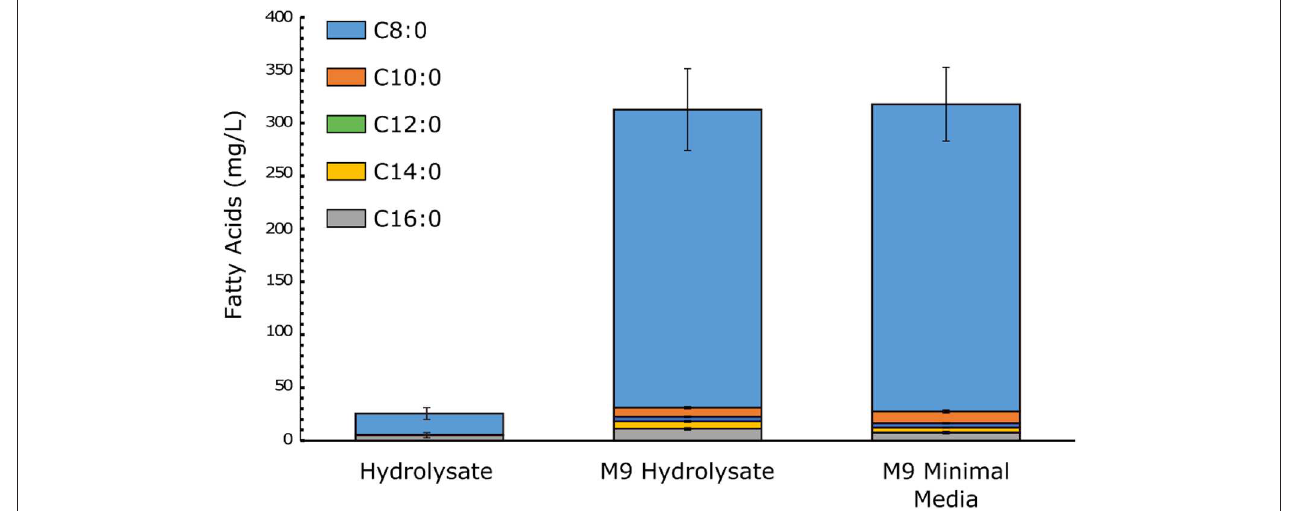
FIGURE 5 | Titers of octanoic acid and other free fatty acids produced by E. coli NHL17. Cells were grown in media containing ∼ 10 g/L glucose. M9 Hydrolysate media was formulated by a 1:1 mixture of M9 minimal media and hydrolysate, leading to total salt concentrations of 0.1mM MgSO 4 , 0.05mM CaCl 2 , 23.9mM Na 2 HPO 4 , 11mM KH 2 PO 4 , 4.28mM NaCl, and 9.35mM NH 4 Cl. The optical density at 24h was 1.1, 2.4, and 1.5, respectively. Error bars represent standard deviation.